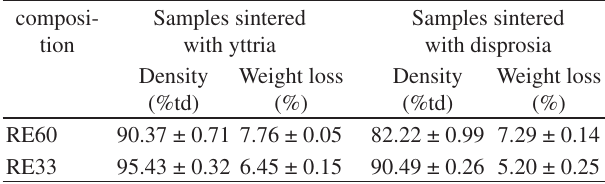
Table 2. Densification results after sintering in graphite resistance furnace.